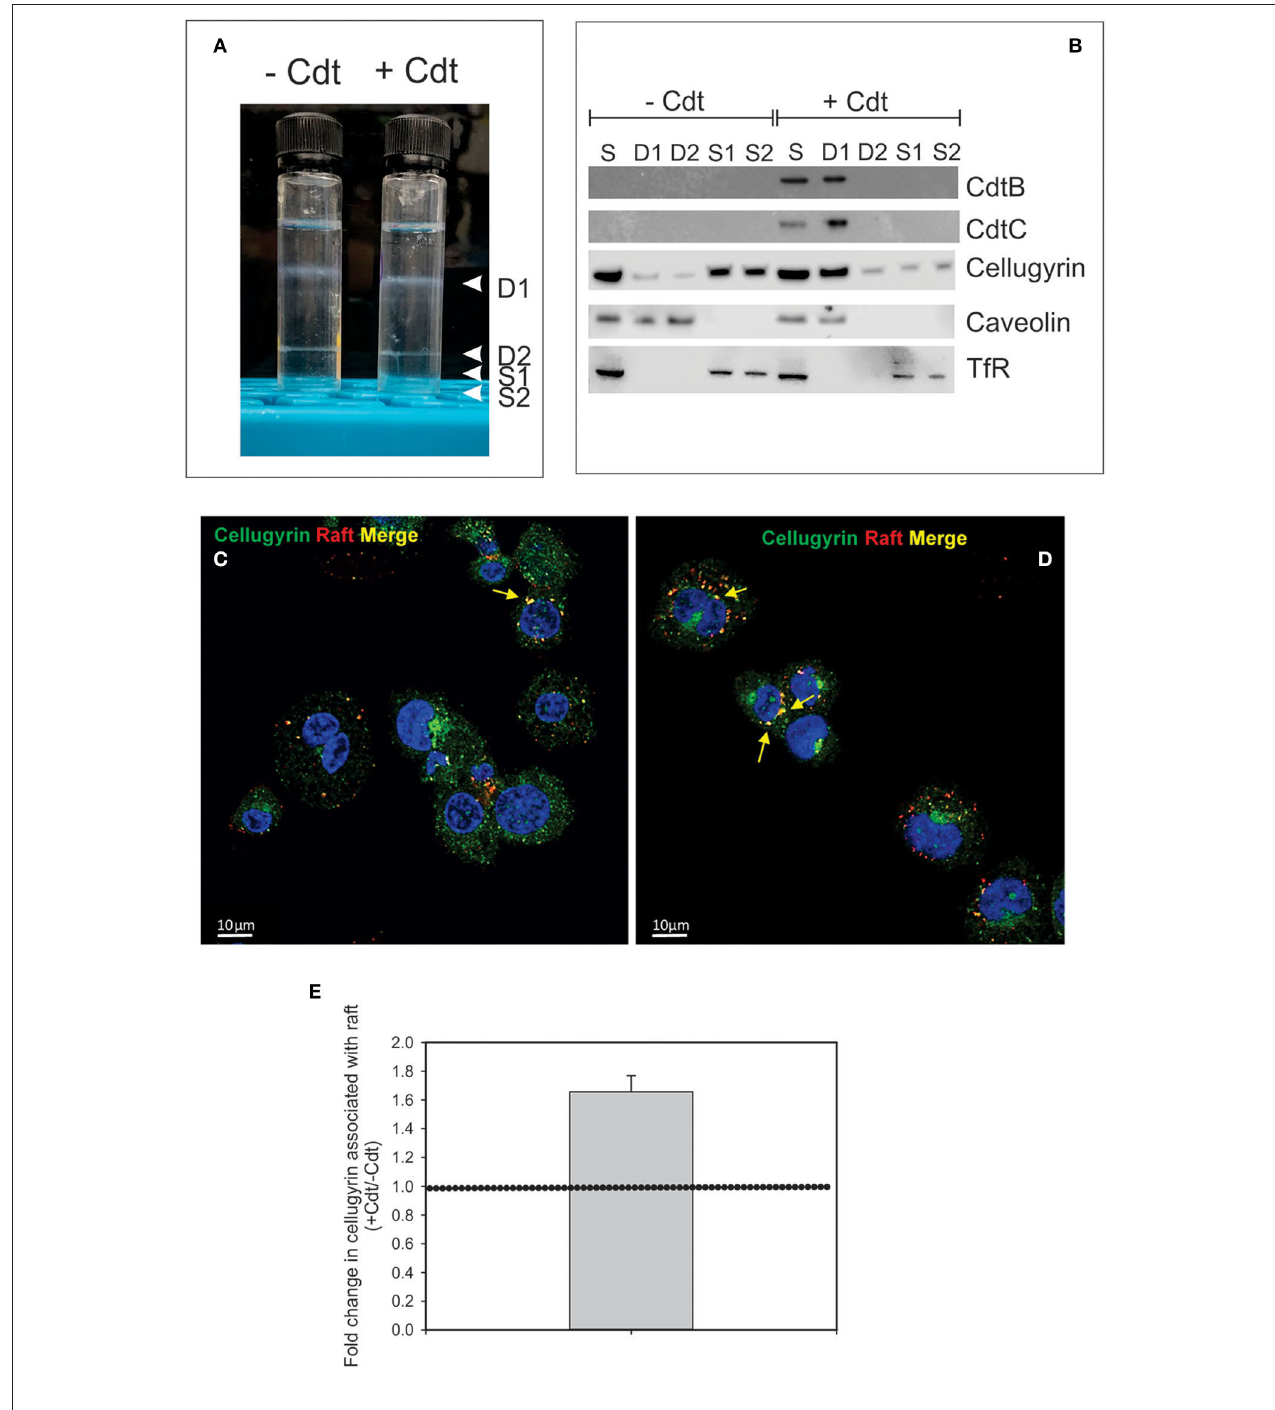
FIGURE 1 | Cdt-induces translocation of cellugyrin to cholesterol rich microdomains. THP-1 WT -derived macrophage were treated with medium or Cdt (1 µ g/ml) for 1h. Cells were harvested, washed, and cholesterol rich microdomains isolated as detergent resistant membranes (DRM) as described in Materials and Methods. (A) Shows the two DRM zones, DRM1 (D1) and DRM2 (D2), on the sucrose gradient; additionally two soluble fractions were collected, designated S1 and S2, which contain the bottom 0.5ml (each) of the gradient. (B) Each fraction was analyzed by Western blot for the presence of CdtB, CdtC, cellugyrin, caveolin (lipid raft marker) and the transferrin receptor (TfR) (non-raft membrane marker). S refers to unfractionated start material. (C,D) Representative confocal images of differentiated untreated THP-1 WT cells (Ctl; C ) or treated with 1 µ g/ml Cdt ( + Cdt; D ) and stained for rafts (red) and cellugyrin (green). (E) Shows the fold change in